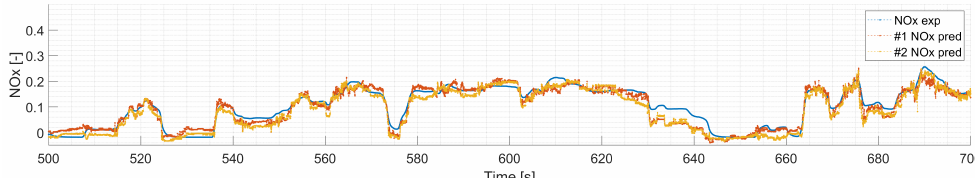
Figure 8. The NOx predicted signals for cases studies #1 and #2, taking into account the line delay of measurement